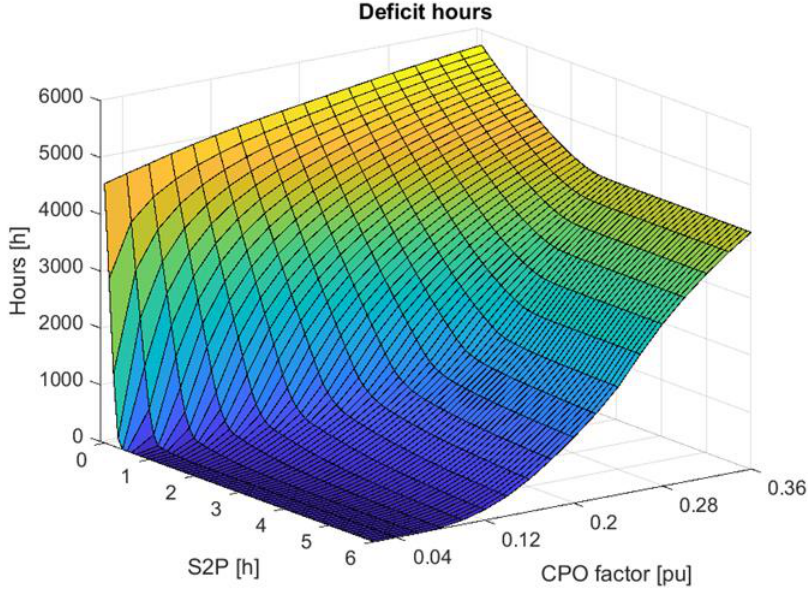
Figure 11. Average annual hours with non-compliance with constant power.